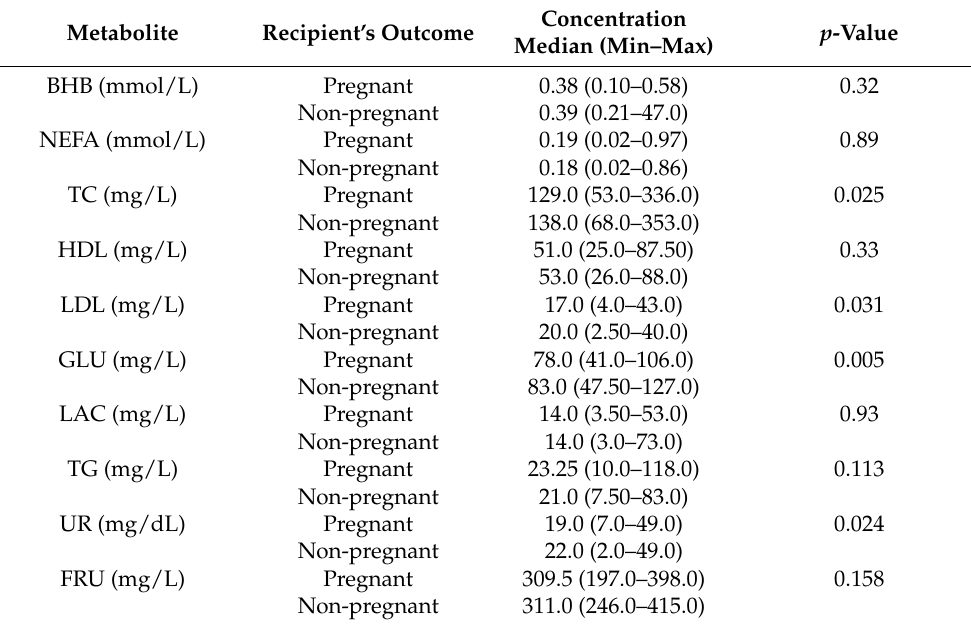
Table 3. Recipients’ plasma metabolites at embryo transfer (ET) of Japanese Black bovine embryos by the final pregnancy status of the recipients after the ET (pregnant vs.